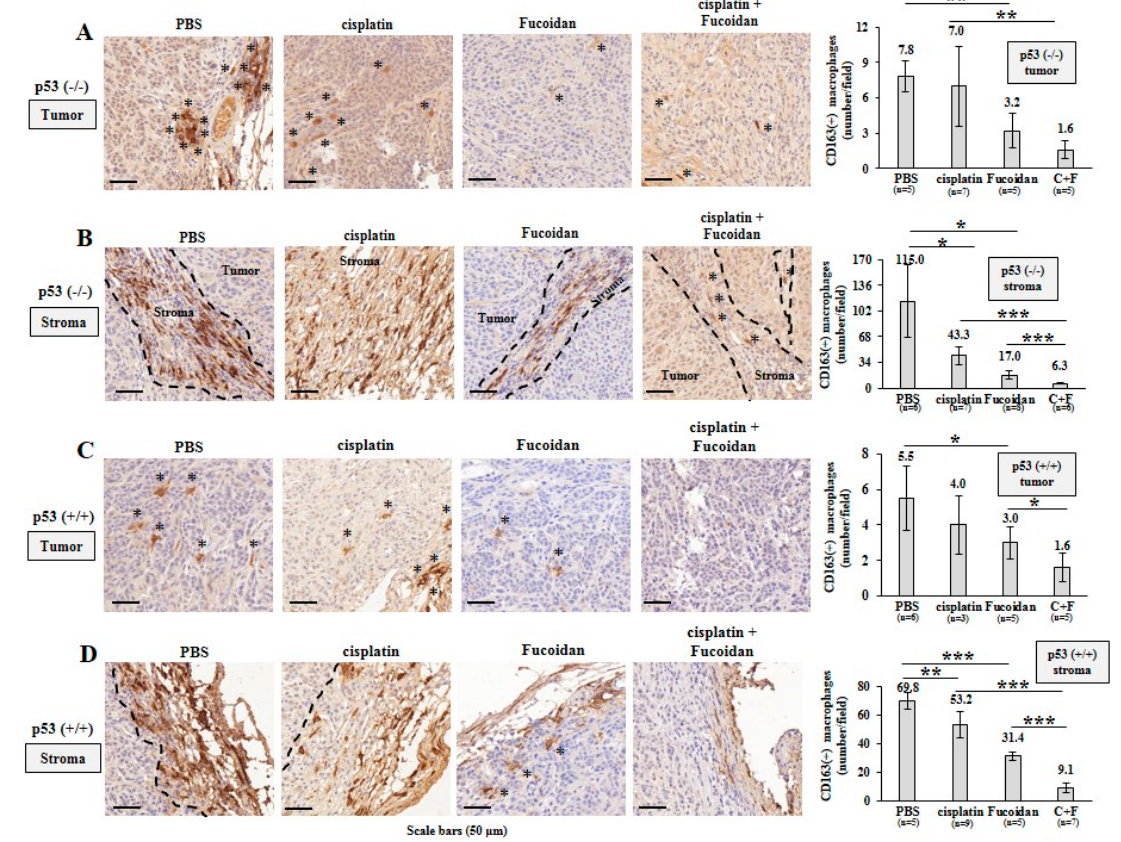
Figure 8. Oligo-Fucoidan alone or in combination with cisplatin inhibits M2 macrophage infiltration. Tumor-associated M2 macrophages were inspected by CD163 immunohistochemistry (IHC) after Oligo-Fucoidan and/or cisplatin treatment. Representative IHC images of CD163(+) M2 macrophages infiltrated into the tumoral ( A ) and stromal ( B ) compartments of p53 − / − tumors were examined. CD163(+) M2 macrophages in the tumoral ( C ) and stromal ( D ) regions of p53 +/+ tumors were assessed.